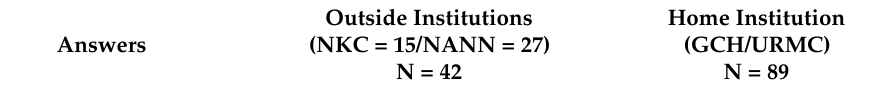
Table 3. Survey responses related to primary